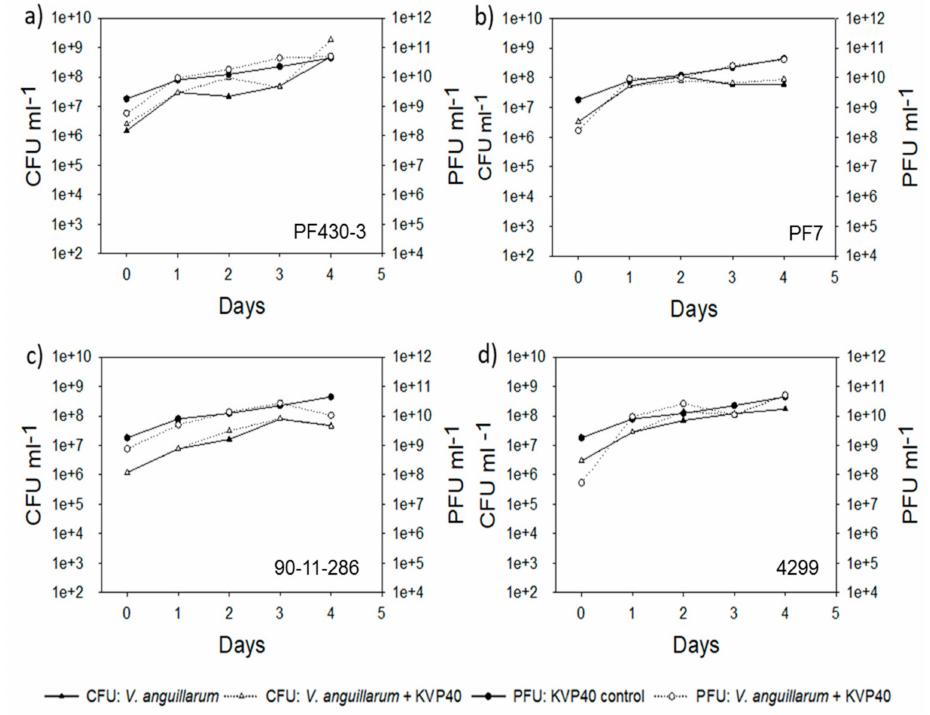
Figure 3. Bacterial abundance (CFU mL − 1 ) and phage abundance (PFU mL − 1 ) in turbot challenge trial 2: ( a ) strain PF430-3; ( b ) strain PF7; ( c ) strain 90-11-286; ( d ) strain